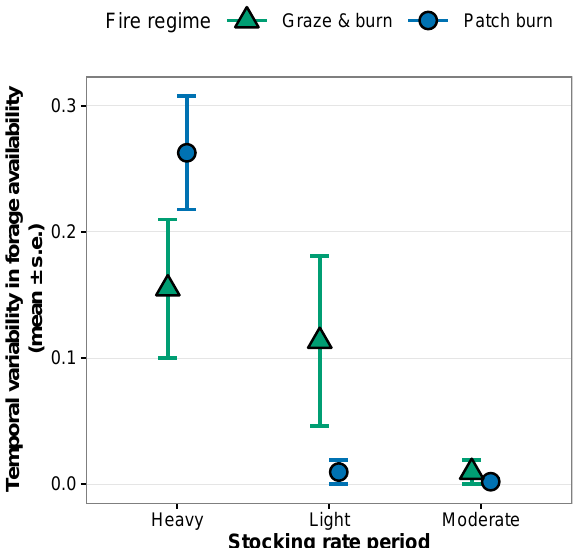
Figure 1. Temporal variability of forage availability—represented as non-destructive measurements of aboveground plant biomass, i.e., standing crop—during three periods of different grazer densities for tall fescue-dominated grassland plant communities under three grazer densities in Iowa, USA, presented as a time series in the order of grazer density treatments: heavy (2007–2009), light (2010–2011), and moderate (2012–2013). Under moderate grazer density, temporal variability of forage availability is lowest in both fire regimes.